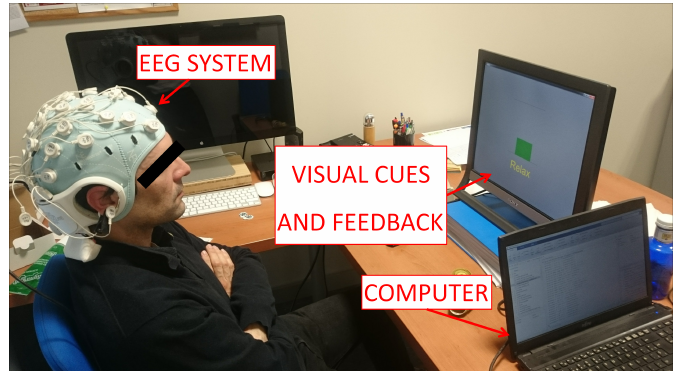
Figure 2. Experimental setup. Subjects sat looking at a screen which fed them with instructions while their EEG signals were recorded. Furthermore, the screen gave feedback about their performance in each task. The participant in the picture gave written informed consent to publish the